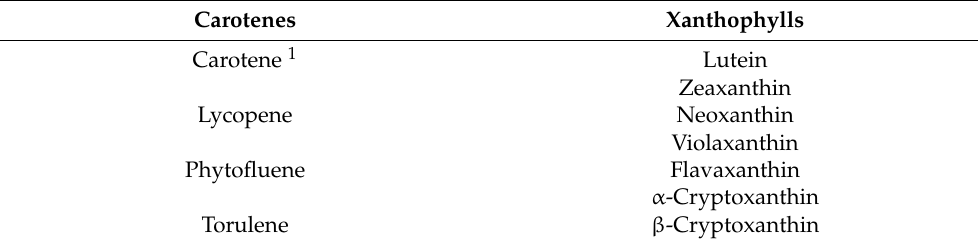
Table 1. Overview of carotenoids found in the diet.